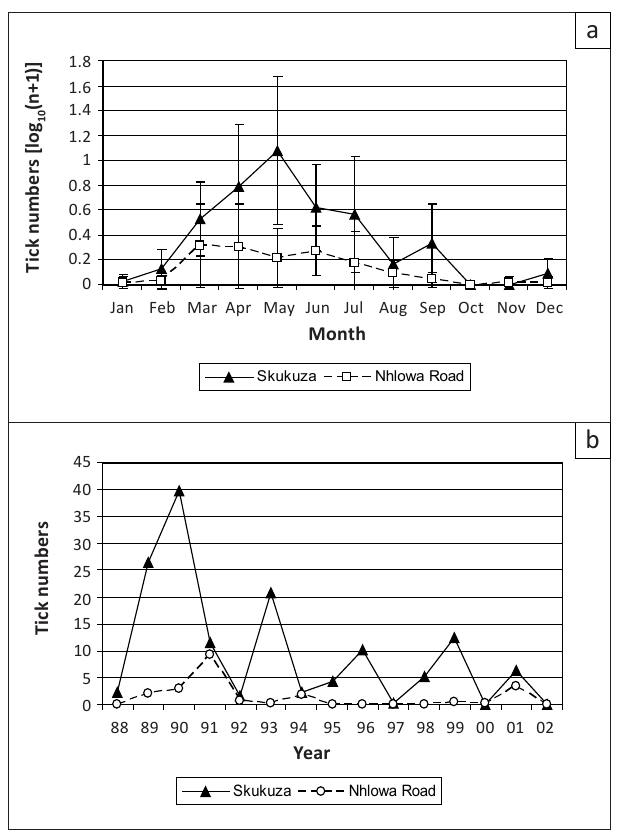
FIGURE 2: (a) Mean collections of Amblyomma marmoreum larvae (mean ± 95% confidence interval) per month and (b) mean monthly collections per year at Nhlowa Road and Skukuza.